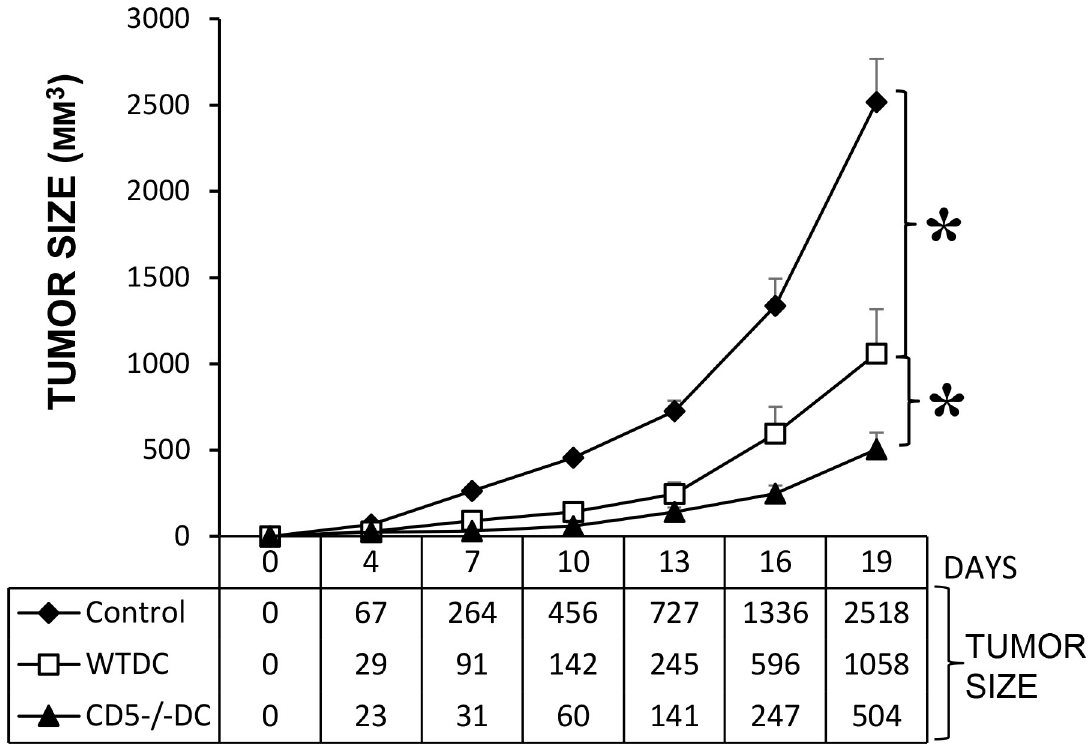
inoculated subcutaneously with mouse EG.7 tumor cells. Tumor size was measured every 3 days (n = 5, � P < 0.05). The data are presented as mean ± SEM and are representative of 2 independent experiments (two-tailed Student’s t